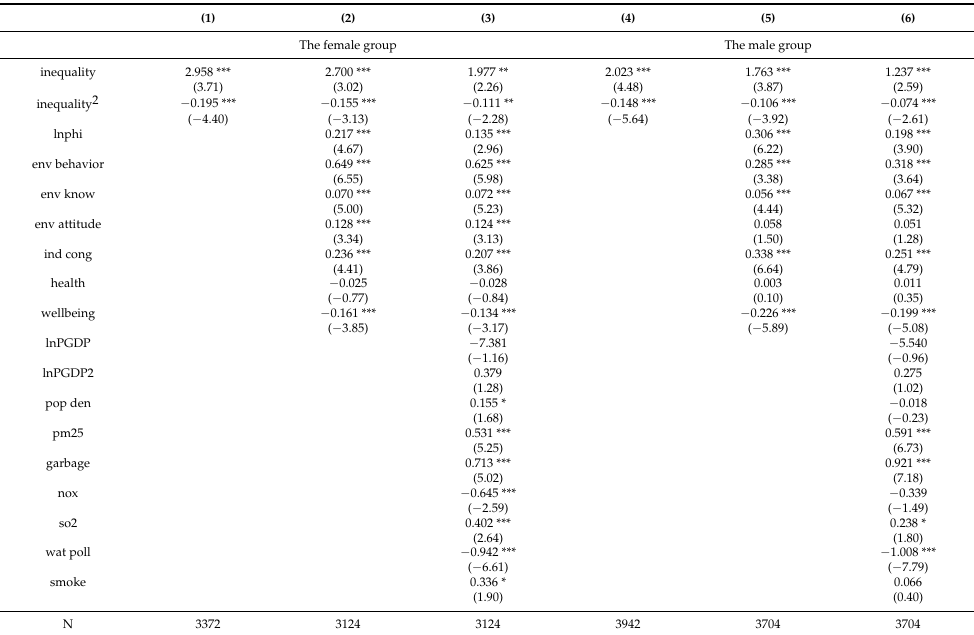
Table A11. The effect of individual-level income inequality on subjective environmental pollution: differences in gender.